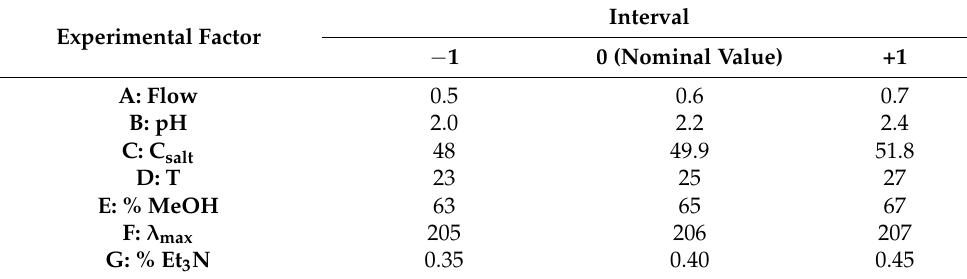
Table 1. Levels of the factors selected for the determination of method robustness.